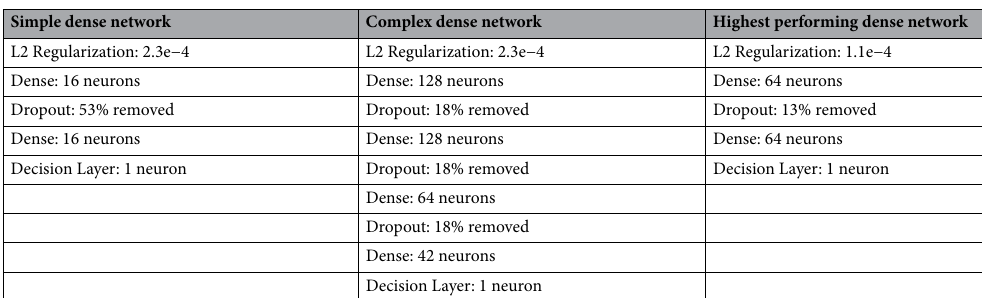
Simple dense network Complex dense network Highest performing dense network L2 Regularization: